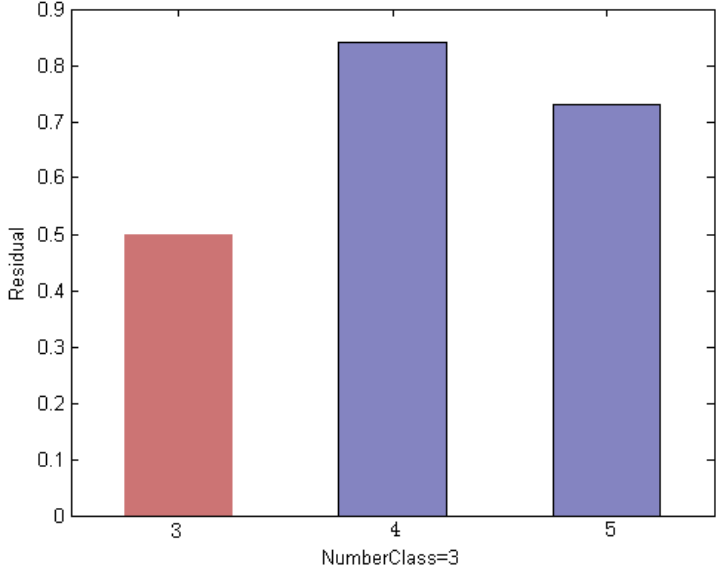
Figure 11. Histogram residual between the test sample and each remaining class obtained by histogram-based measurements. This shows that the test sample with the minimum reconstruction error is assigned to the label of the 3rd class, which leads to correct classification